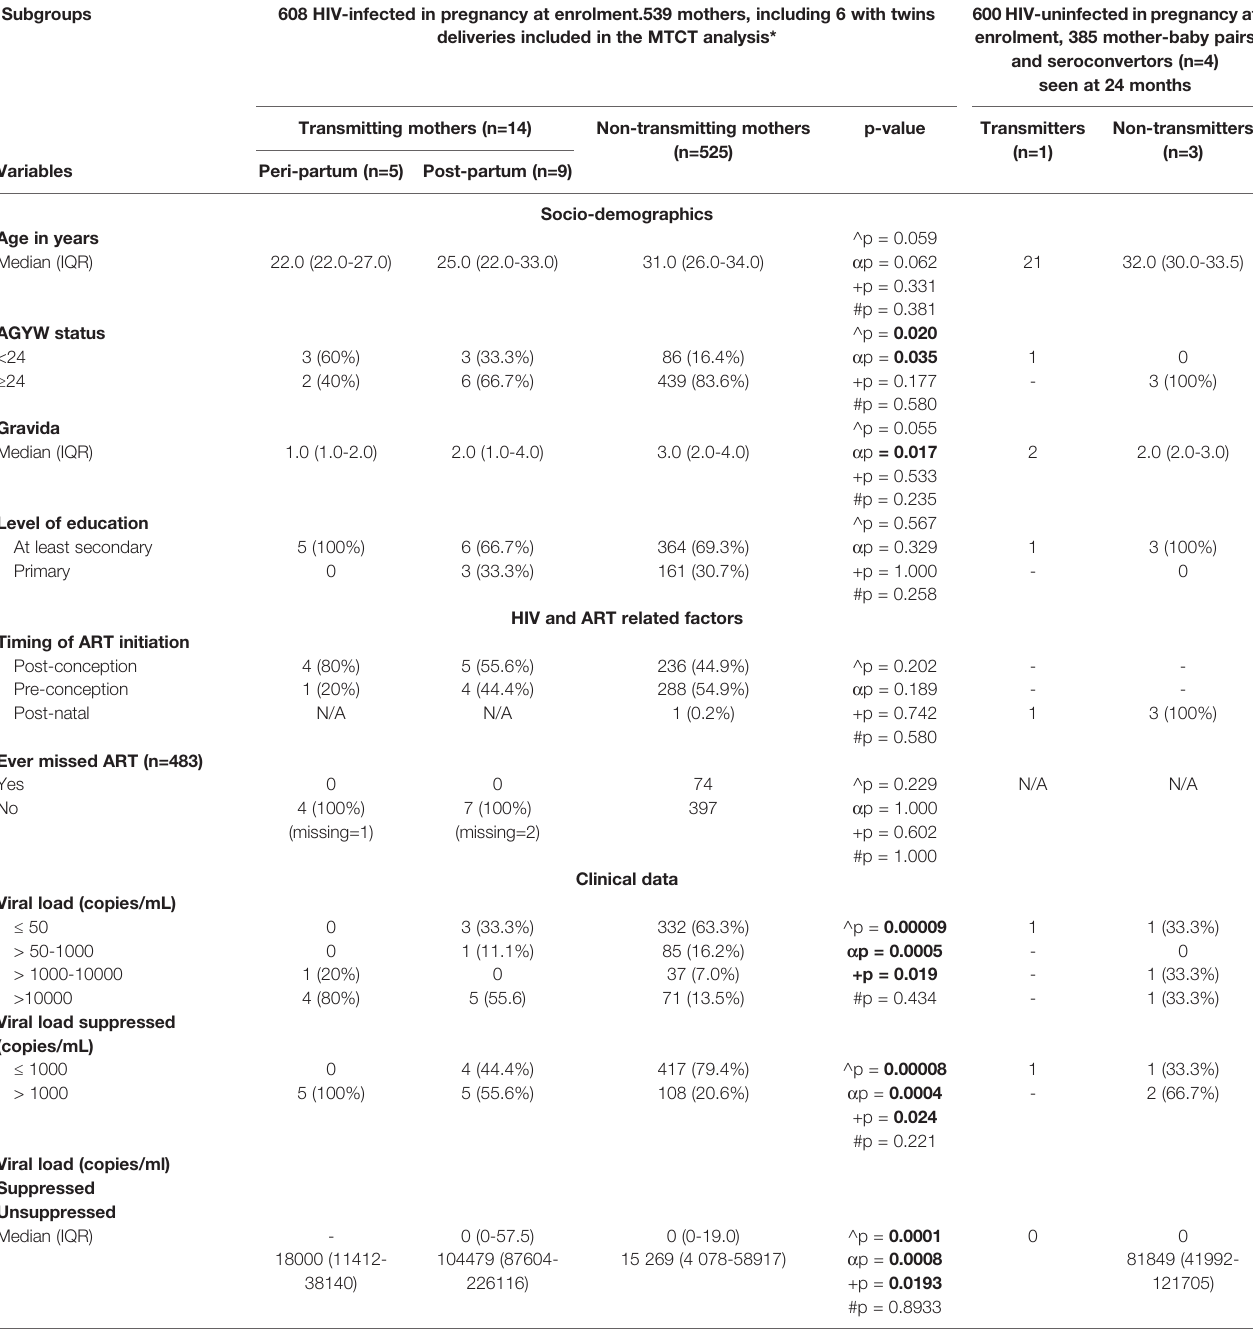
TABLE 1 | Demographic and clinical characteristics, HIV- and ART-related factors, and delivery outcomes including infant factors of HIV-infected transmitting (n = 14) and non-transmitting mothers (n = 525) already infected in pregnancy at enrollment plus four mothers sero-converting after delivery from whom one transmitted at 6 months after